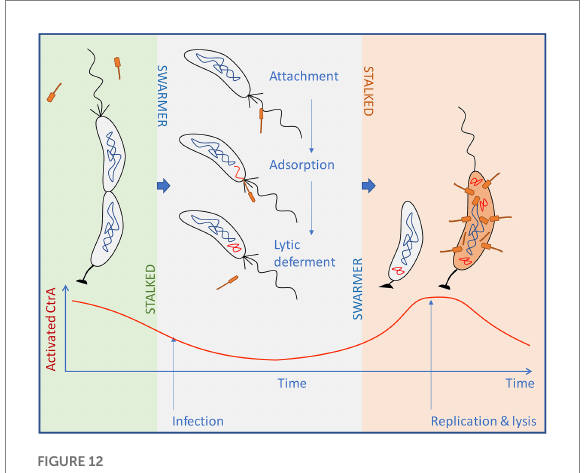
FIGURE 12 Schematic representation of the proposed life cycle for Φ Cbk- like phages. Phages infecting Caulobacter -like species require the pili/flagella present in swarmer cells for infection. Upon infection, cells encounter non-peak levels of activated CtrA and defer the lytic cycle. After the swarmer cell transitions to a stalked cell, levels of activated CtrA start to rise, eventually triggering the expression of phage genes and the development of the lytic cycle in an environment where swarmer cells are being